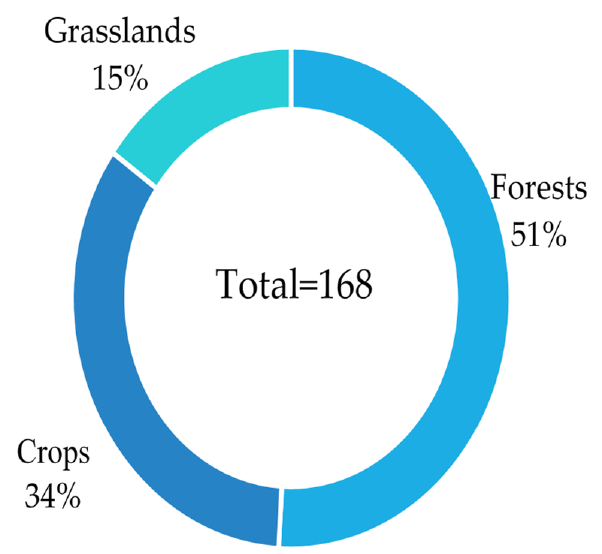
Figure 1. Number of LAI studies for forests, crops and grasslands.